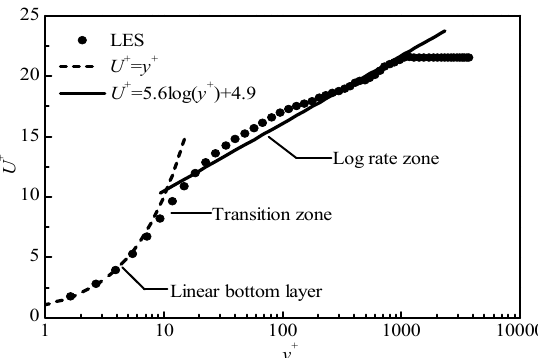
Figure 3. Comparison of Large Eddy Simulation (LES) and theoretical values [41,42] for turbulent boundary layer velocity distribution. The data are extracted from the area below 20 mm downstream from the obstacle line and are shown after ensemble averaging.